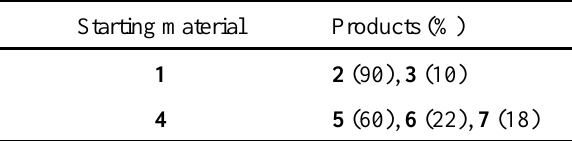
Table 1. Product compositions of the phosphine-BMS